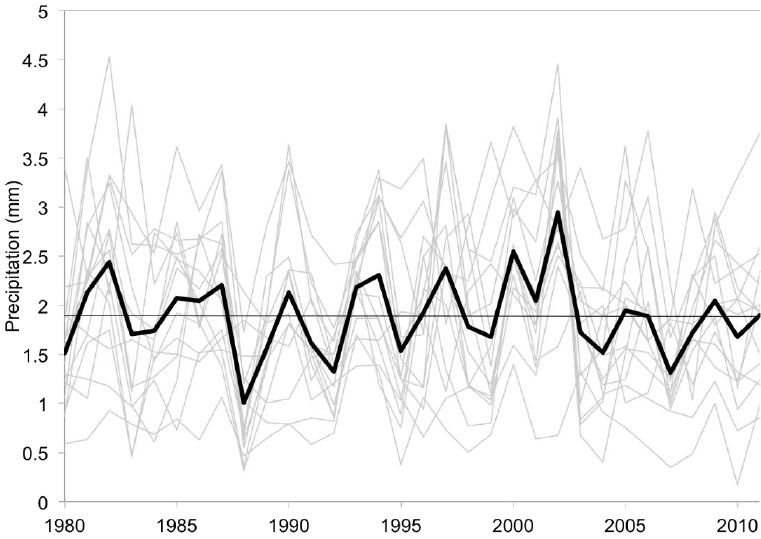
Figure 6. This graph shows the post-monsoon average daily precipitation (mm). The post monsoon is defined as the time period between the monsoon retreat and 31 December. The black line indicates the average daily precipitation across all provinces and the grey lines indicate the average daily precipitation for each province.